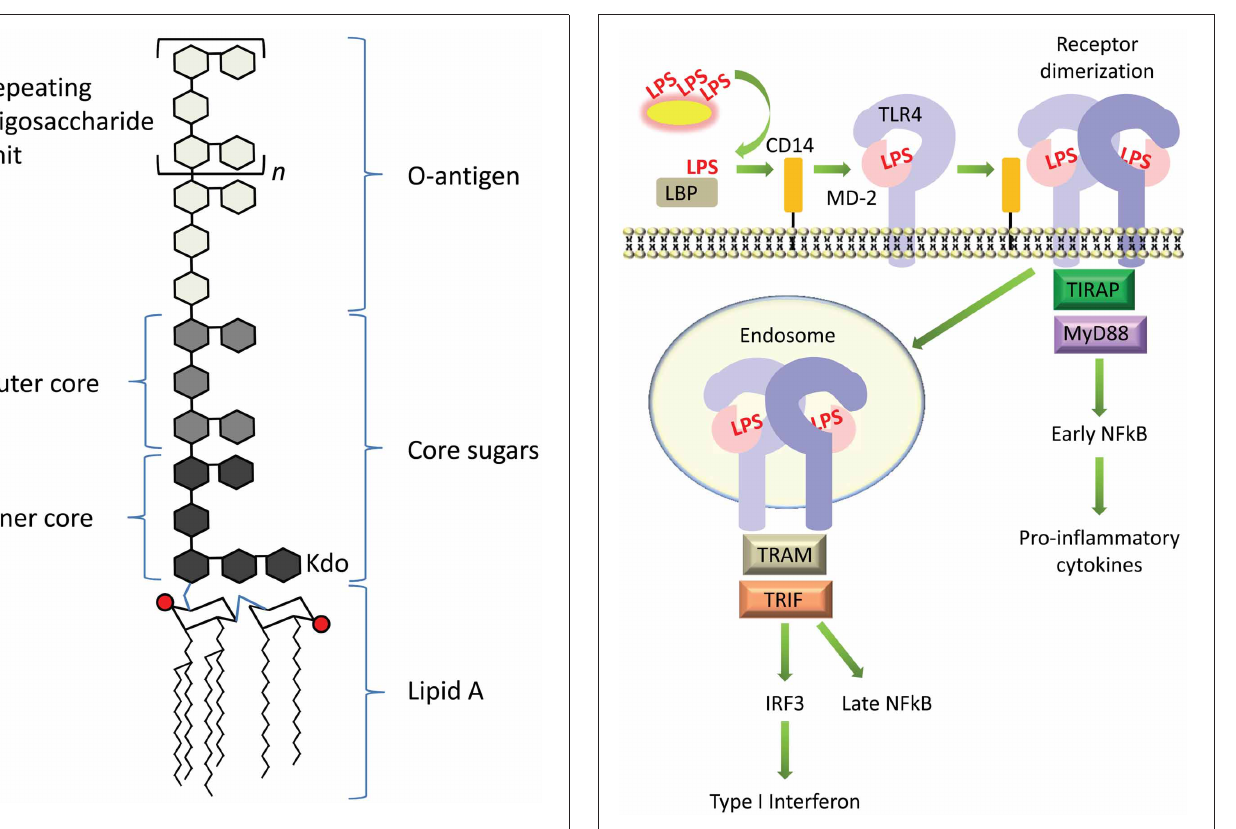
FIGURE 2 | Simplified diagram of signaling by LPS on host cells. LPS is extracted from bacterial membranes by LPS binding protein (LBP) in serum, passed to CD14, then transferred to MD-2 and TLR4, which form a complex on the cell surface. LPS-induced receptor dimerization is followed by recruitment of the adaptor proteins TIRAP and MyD88, which promotes activation of the transcription factor NF κ B. The TLR4-MD-2 complex can also be internalized, which recruits a different set of adaptor proteins, TRIF and TRAM, promoting activation of IRF3 and production of type I interferons, as well as delayed activation of NF κ